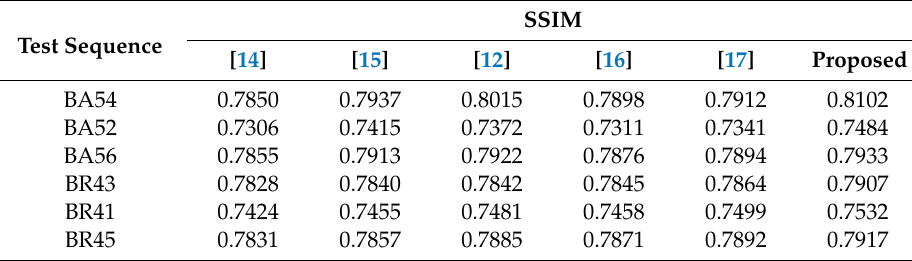
Table 2. Average structural similarity (SSIM) comparison of the proposed and previous